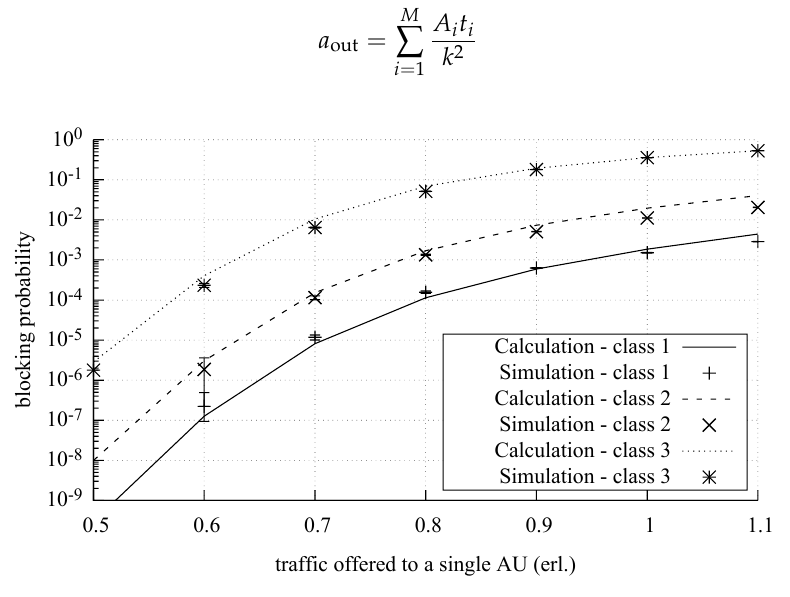
Figure 7. Blocking probability in the switching fabrics with u = 0 deactivated switches.